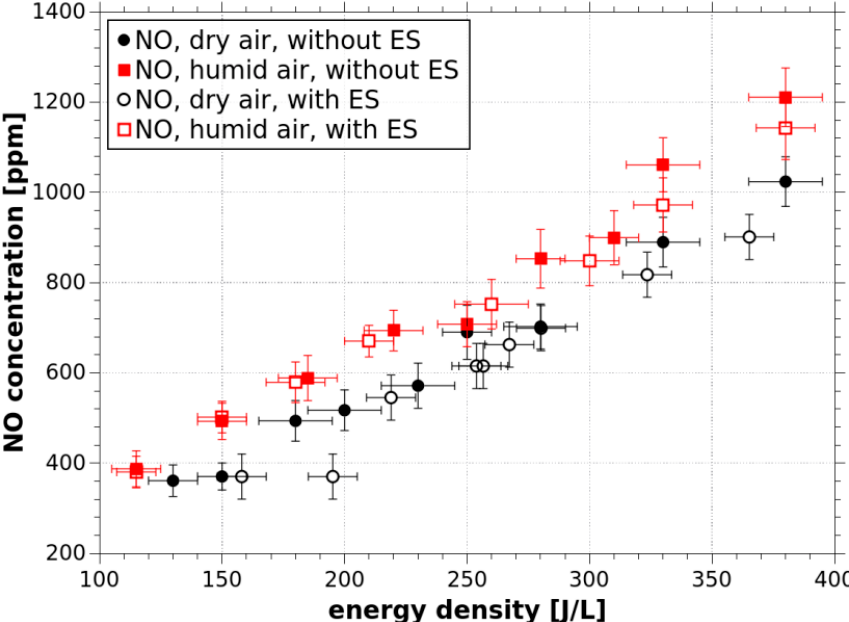
Figure 11. Comparison of NO concentration produced by TS in the first reactor, with and without ES (Q w = 500 μ L/min) in the second reactor (2SS), measured by UV-Vis absorption technique, short cell.